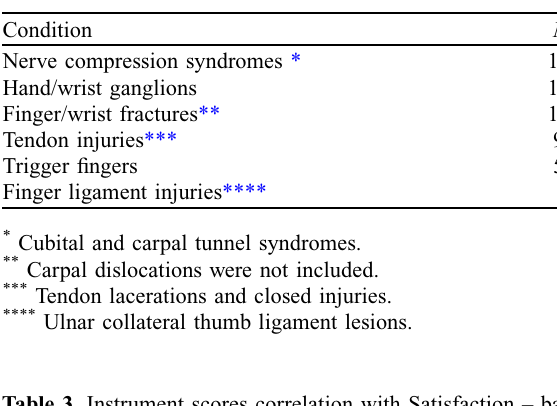
Table 2. Patient conditions that resulted in surgical treatment.